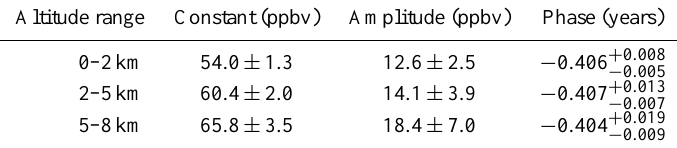
∗ The seasonal cycle was constructed from a harmonic fit of the CGOP observations in each altitude bin. Only the first harmonic term in each fit was statistically significant at the p = 0 . 05 level or better, and those coefficients are shown here along with their 95% confidence intervals. The fitted seasonal cycle in each bin, shown in Fig. S5, can be reconstructed as